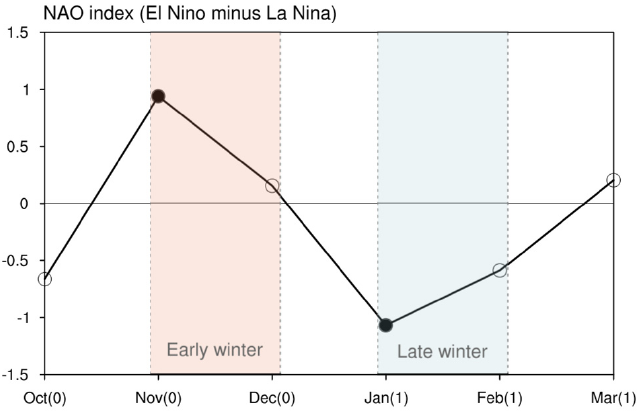
Figure 1. SLP anomalies (hPa) in ( a ) November, ( b ) December, ( c ) January, and ( d ) February regressed upon the simultaneous standardized NAO index. ( e – h ) Similar to ( a – d ) but for SLP anomalies regressed on the Niño3.4 index. Large (small) dots indicate regression coefficients that are statistically significant at the 95% (90%) confidence level. The green box indicates the North Atlantic region (20 ◦ –90 ◦ N, 0 ◦ –80 ◦ W). The pattern correlation is displayed in ( e – h ), which is calculated based on the NAO-related SLP anomalies and ENSO-related anomalies over the North Atlantic region for each month, respectively.